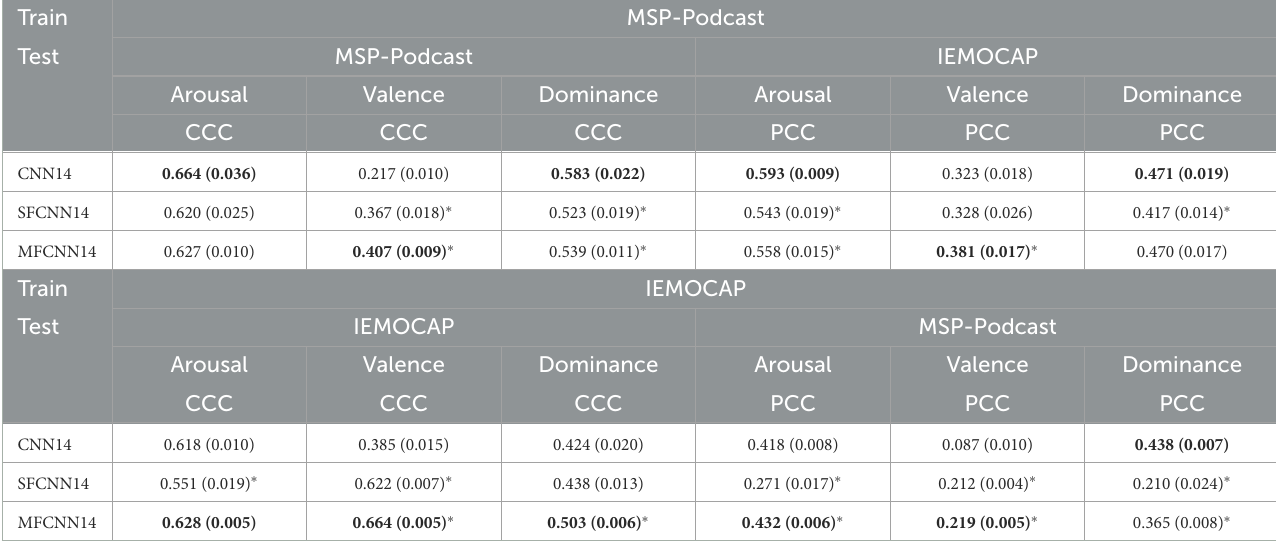
TABLE 2 CCC/PCC in-/cross-domain results for emotional dimension prediction using single-task models trained with an MSE loss. Train